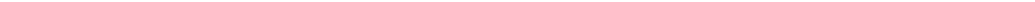
(see fi gure on previous page) Fig. 1 INGAP pre-treatment partially inhibits cytokine cytotoxicity in RINm5F β cells. Cells were pre-treated for 2 h with 1 nM rINGAP or 1.67 μ M Ingap-p and exposed to cytokines 100 pg/mL IL-1 β and 1 ng/mL IFN γ . A Metabolic activity was assessed by MTT assay after 24, 48, and 72 h of cytokine treatment. Values were normalized to vehicle control (PBS) and expressed as fold change. All data represent the mean of at least three independent experiments ± SEM * p < 0.05 and ** p < 0.01 vs. time-matched treatment with cytokine alone; multiple t test comparisons corrected by the Sidak – Bonferroni method. Here and thereafter rINGAP and Ingap-p are shortened to rING and Ing-p, respectively. B , C Assessment of apoptosis by Annexin-V/PI staining after 48 h of cytokine treatment. B Representative dot plots of FITC- fl uorescence ( x axis) versus PI- fl uorescence ( y axis) are shown. Quadrant representation: lower left, live cells; lower right, early apoptotic cells; upper left, necrotic cells; upper right, late apoptotic and necrotic cells. C Percentage of total apoptotic cells was determined by summation of lower and upper right quadrants and represented as bar graphs. *** P < 0.001 vs. treatment with cytokine alone; one-way ANOVA with Bonferroni corrected multiple comparisons. D – G Level of caspase-3 assessed by Western blot. D , F Representative stain-free blots of cell lysates after 24 and 48 h cytokine treatment. E , G Densitometric analysis presented as relative quantities of cleaved caspase-3 normalized to total lane protein and expressed as fold change. All data represent the mean of at least three independent experiments± SEM * p < 0.05 and *** p < 0.001 vs. time-matched treatment with cytokines only; multiple t test comparisons corrected by the Sidak – Bonferroni